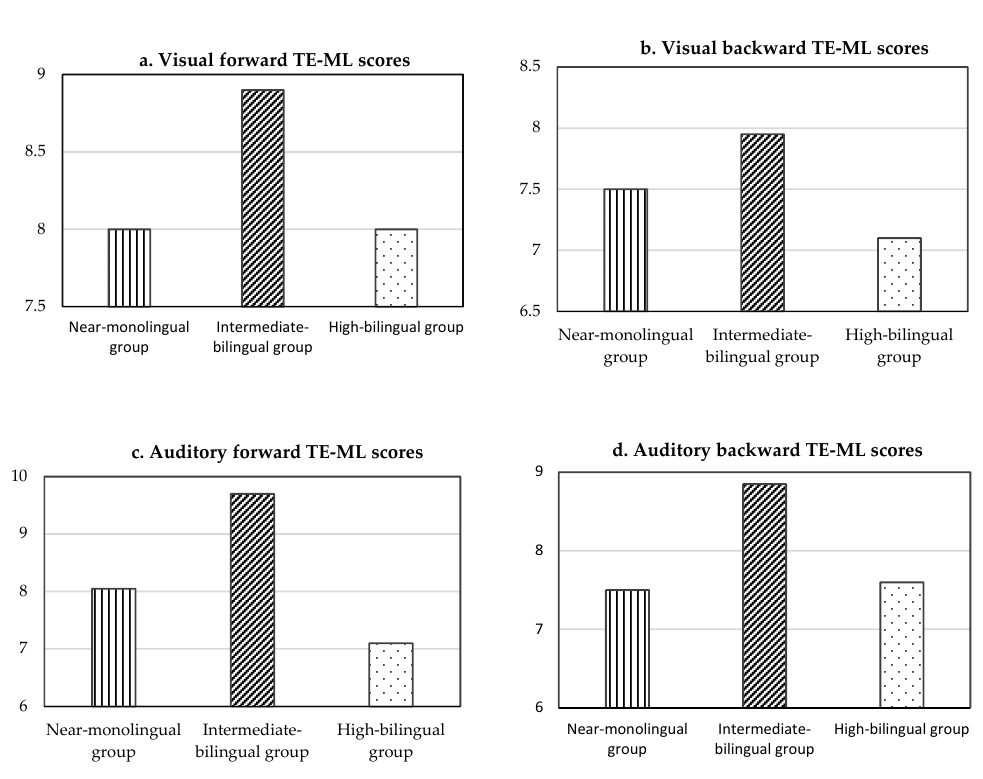
Figure 1. Group mean comparisons in TE-ML scores. ( a ) Visual forward two-error maximum length of three language groups; ( b ) Visual backward two-error maximum length of three language groups; ( c ) Auditory forward two-error maximum length of three language groups; ( d ) Auditory backward two-error maximum length of three language groups.